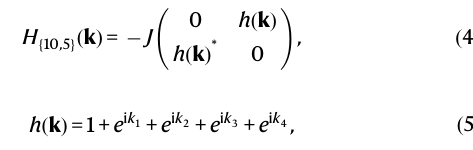
boundarycontributionremoved,itagreeswellwithbandtheory. c Bulk-DOSofa{7, 3} fl ake with 847 sites vs. band theory. d The averaged DOS of fi ve {8, 3} regular maps (each with ~2000 sites) reveals excellent agreement with band